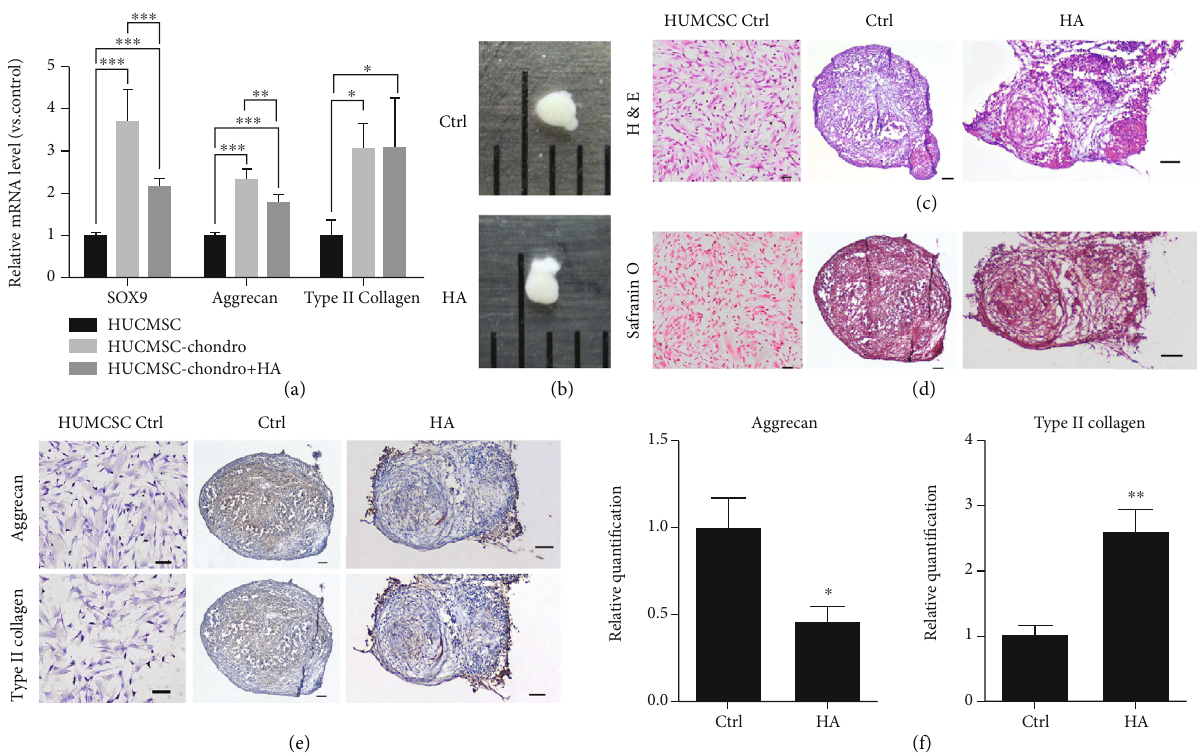
Figure 3: qRT-PCR and immunohistochemistry (IHC) of HUCMSCs after chondrogenic di ff erentiation. (a) Expression of chondrogenic genes ( SOX9 , aggrecan , and type II collagen ) in HUCMSCs is treated with or without hyaluronic acid (HA) compared to no di ff erentiation HUCMSCs. (b) The gross picture of the pellet di ff erentiated from HUCMSCs is treated with or without HA. (c) H&E staining of the pellet and HUCMSC (negative control). (d) Safranin O staining of the pellet and HUCMSC (negative control). (e) IHC of aggrecan and type II collagen of the pellet and HUCMSC (negative control). (f) The quanti fi cation of aggrecan and type II collagen. Scale bar = 100 μ m . ∗ p < 0 : 05 , ∗∗ p < 0 : 01 , and ∗∗∗ p < 0 : 001 . Ctrl: